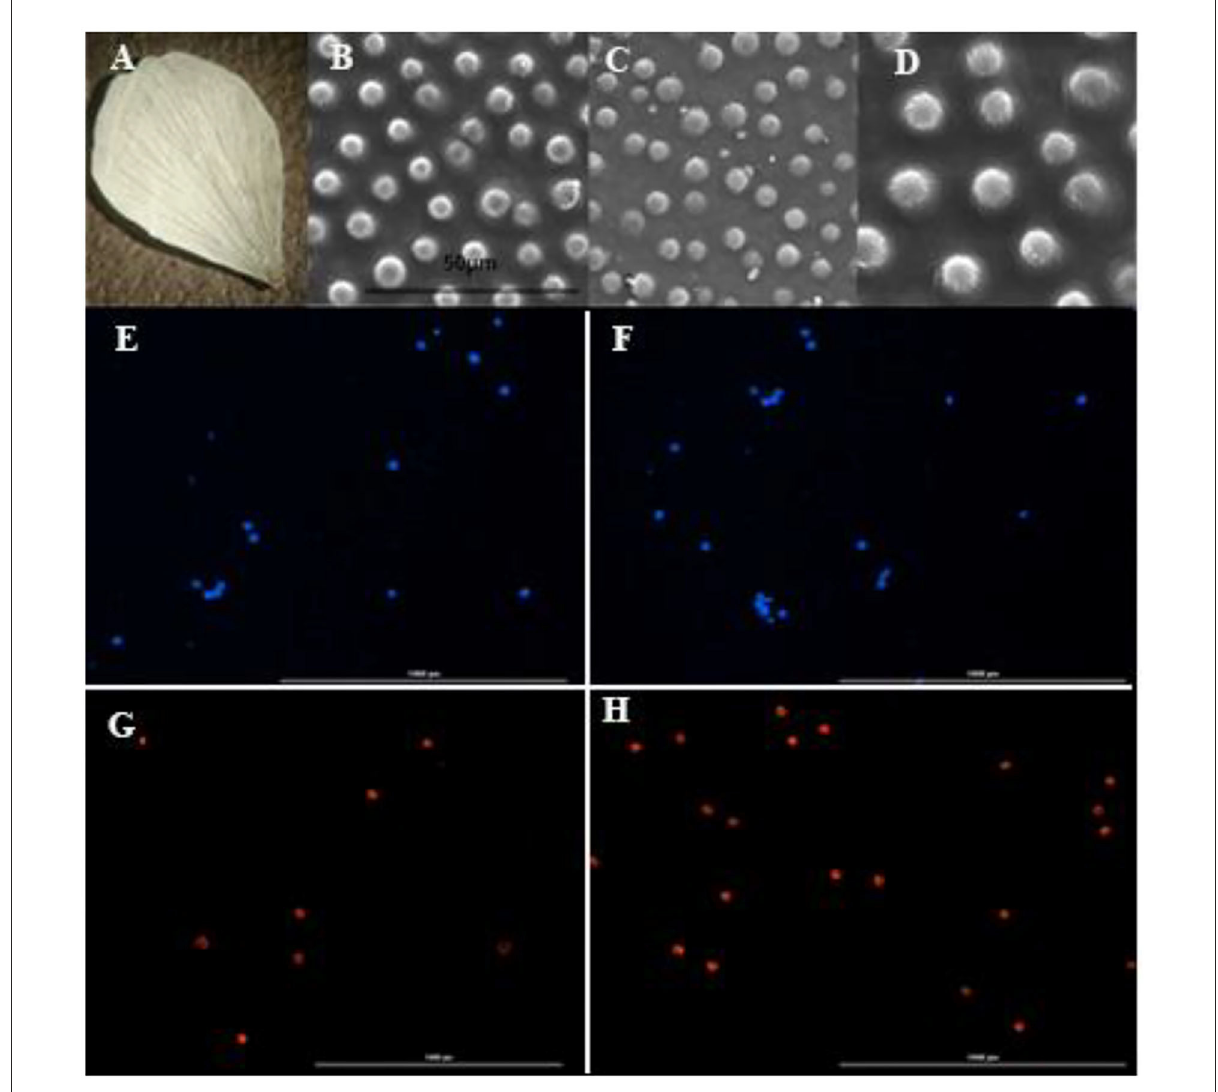
FIGURE3 Electron microscopy of petal and fluorescent microscopy of pollens in diploid, tetraploid and octaploid plants of Rubus persicus blackberry. (A) Blackberry petal, (B) conical shape of diploid plants, (C) conical shape of tetraploid plants, (D) conical shape of octaploid plants, (E) pollen number of octaploid flower stained by DAPI, (F) pollen number of diploid flower stained by DAPI, (G) viable pollen number of octaploid flower stained by PI, (H) viable pollen number of diploid flower stained by PI. The scale bar in the pollen image showed 1,000 µ